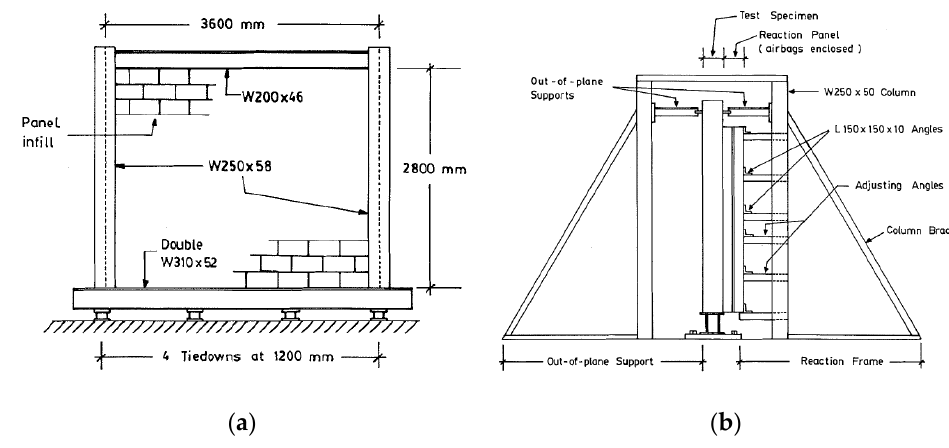
Figure 2. Experimental design [7]: ( a ) geometry of tested frames; ( b ) test setup.